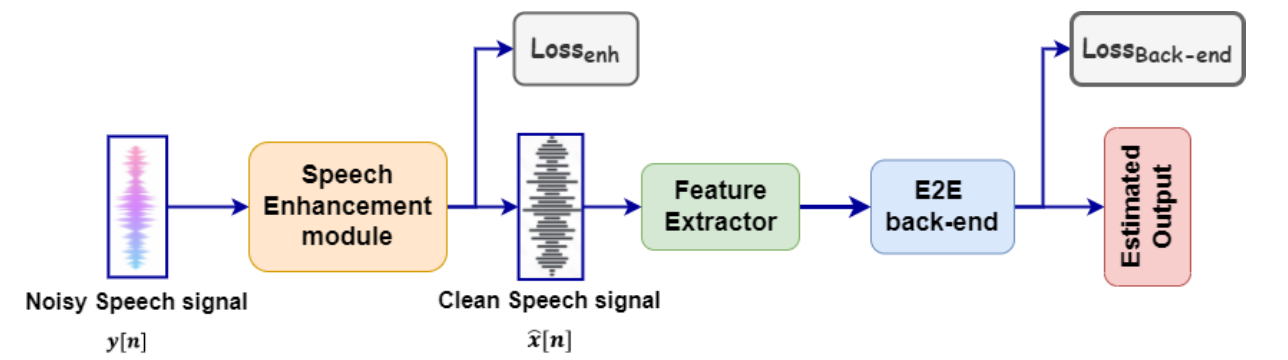
Figure 2. Schematic diagram of the conventional joint training speech enhancement with different